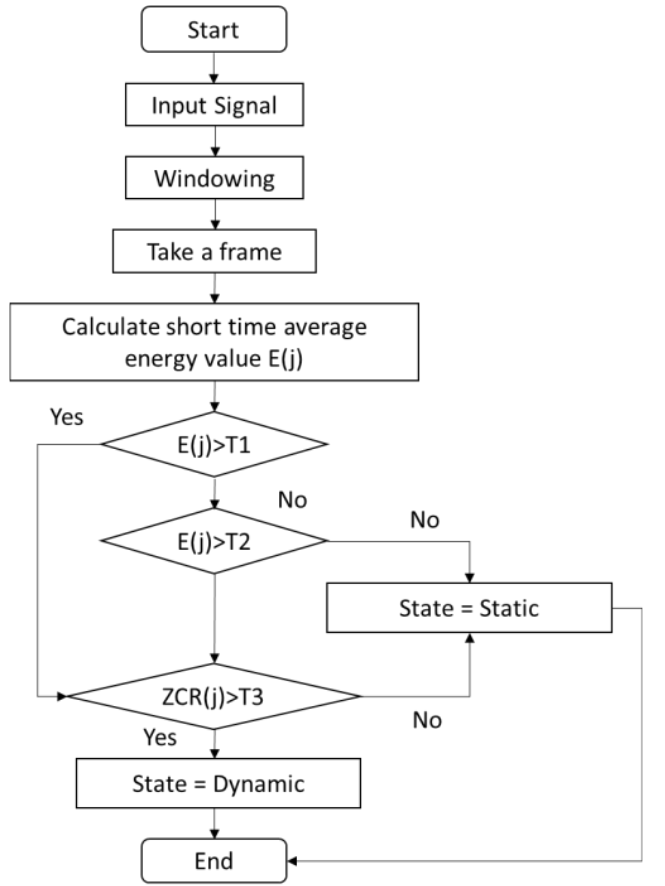
Figure 7. Flow-chart of double threshold method.